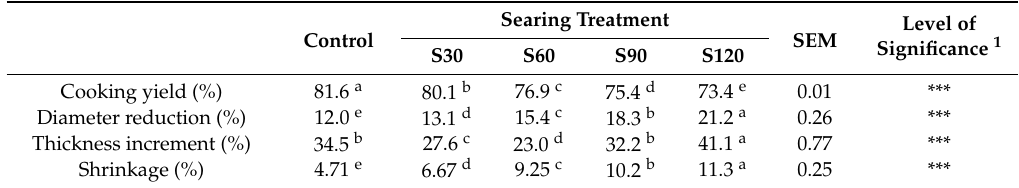
Table 2. E ff ects of searing process on cooking properties of sous-vide cooked pork patties.